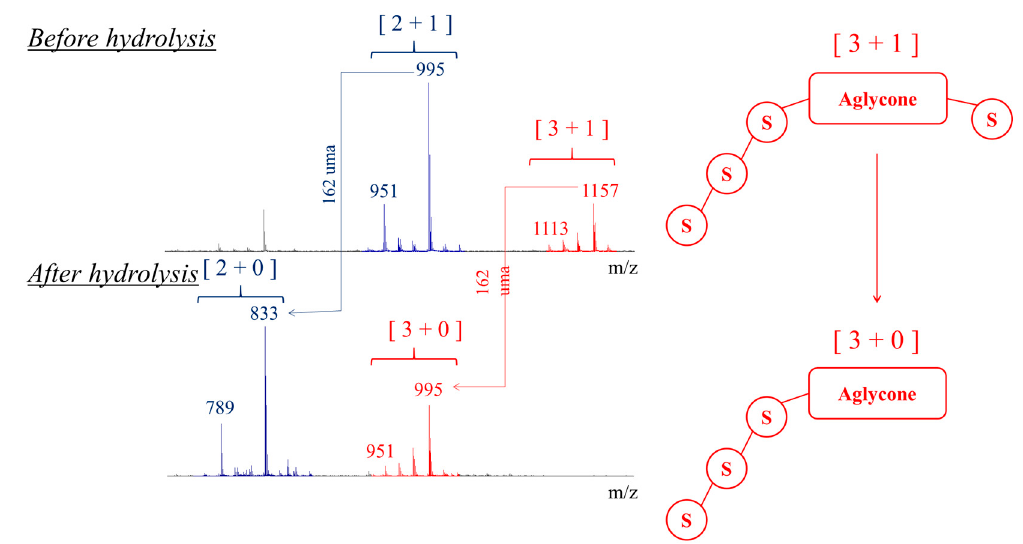
Figure 8. Microwave-assisted alkaline hydrolysis (5min, pH 10, 150 °C) of Chenopodium quinoa saponin extract: MALDI (+) mass spectra of ( a ) the saponin extract and ( b ) the hydrolyzed saponins.